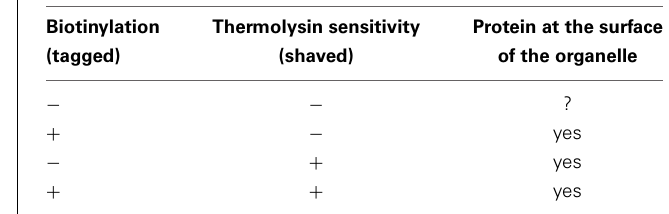
Table 1 | Initial assessment of envelope peripheral protein topology after “tag” or “shave” positive